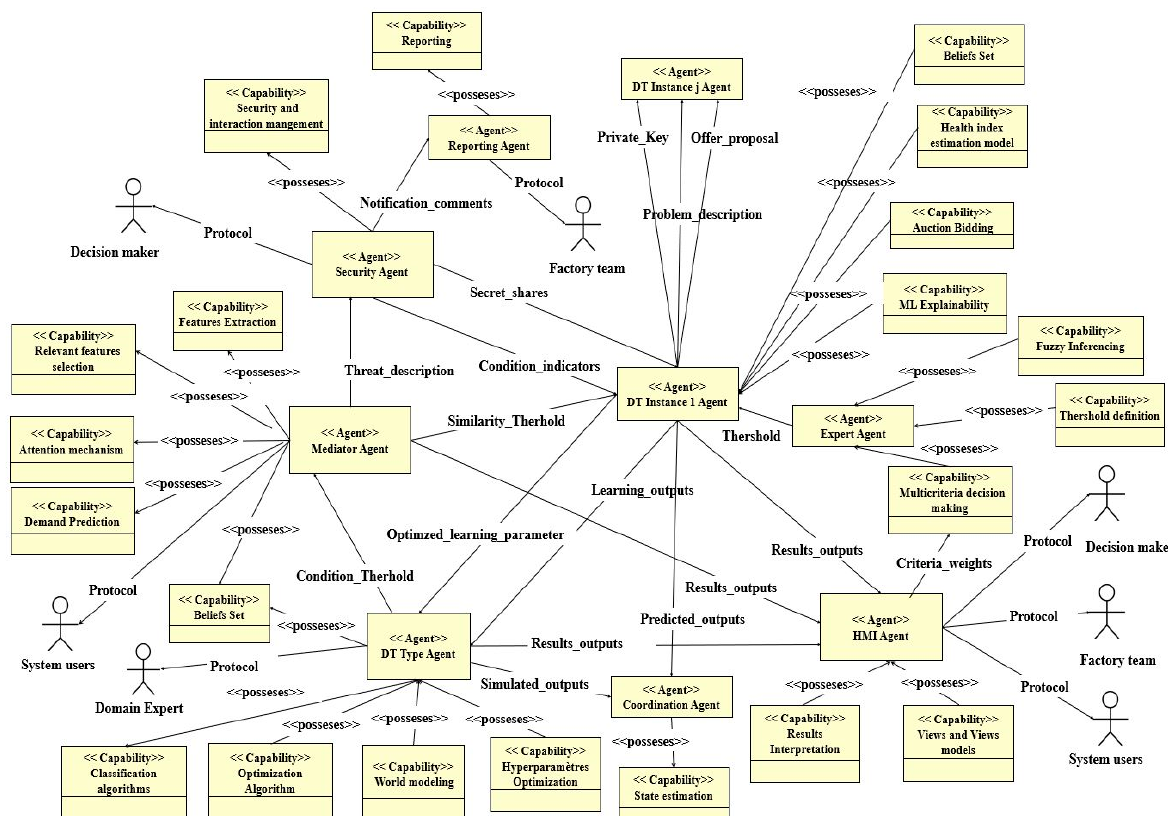
Figure 7. HT OMASE society view for the use case—agent class model.